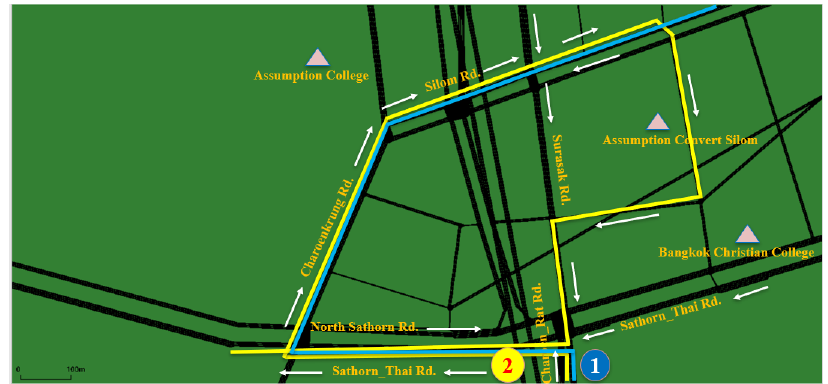
Figure 3. Simulated additional traffic routes representing parent trips to drop off students at local schools during morning rush hour.